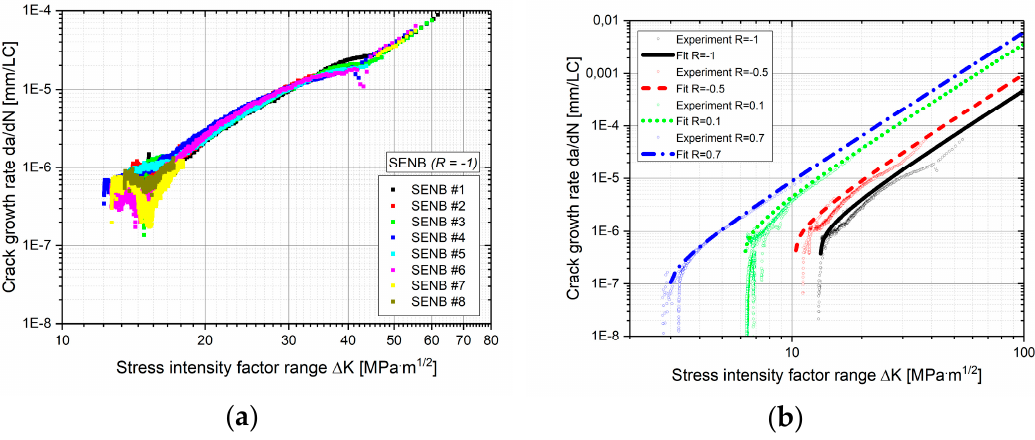
Figure 4. Experimental crack growth diagrams of SENB samples; ( a ) test data of eight specimens at a stress ratio R = − 1; ( b ) Comparison of results and fit for different stress ratios from R = − 1 to R = 0.7.